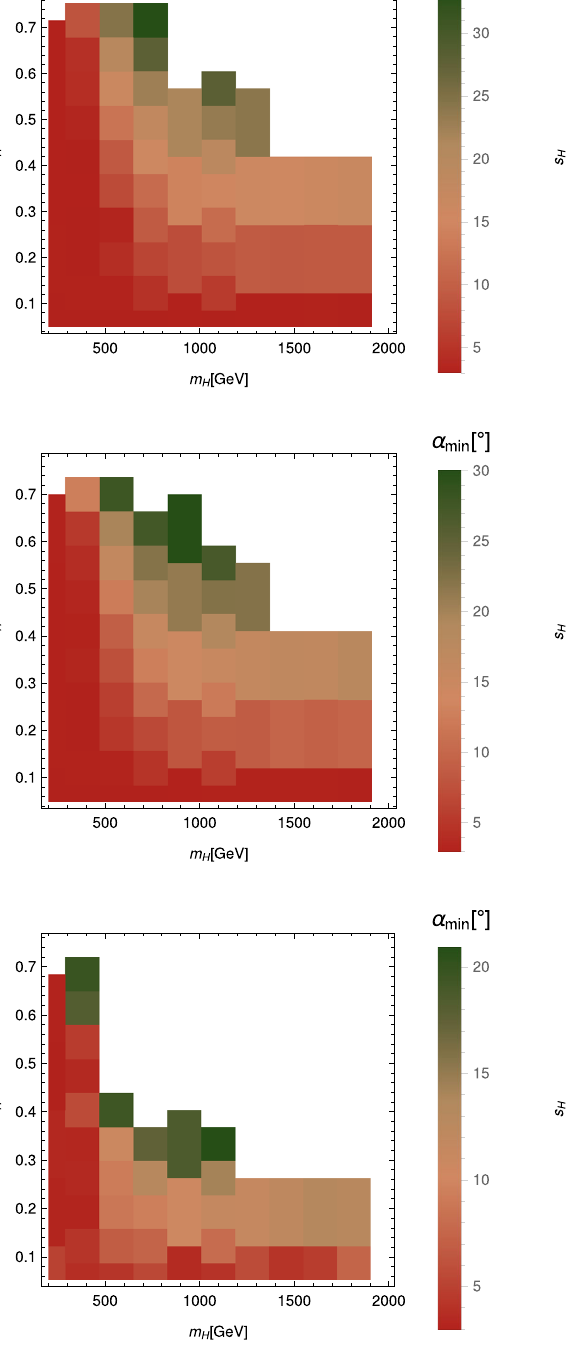
All regions where only for Input I, points had survived the HiggsBounds cuts, are in conflict with the (weak) pertur- bativity constraints. Thus, the accessible regions as well as